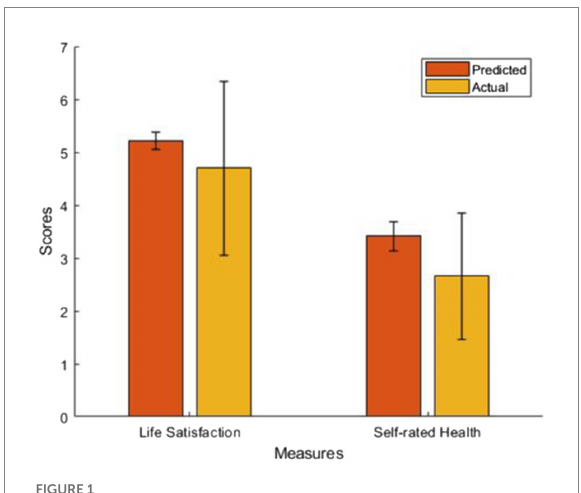
FIGURE 1 The predicted and actual score of life satisfaction and SRH in people with epilepsy given their demographics based on the generalized linear models trained on people without